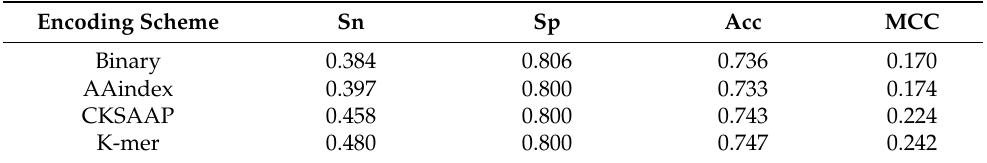
Table 3. Prediction performance of the single encoding-employing models without any feature selection on the independent dataset.